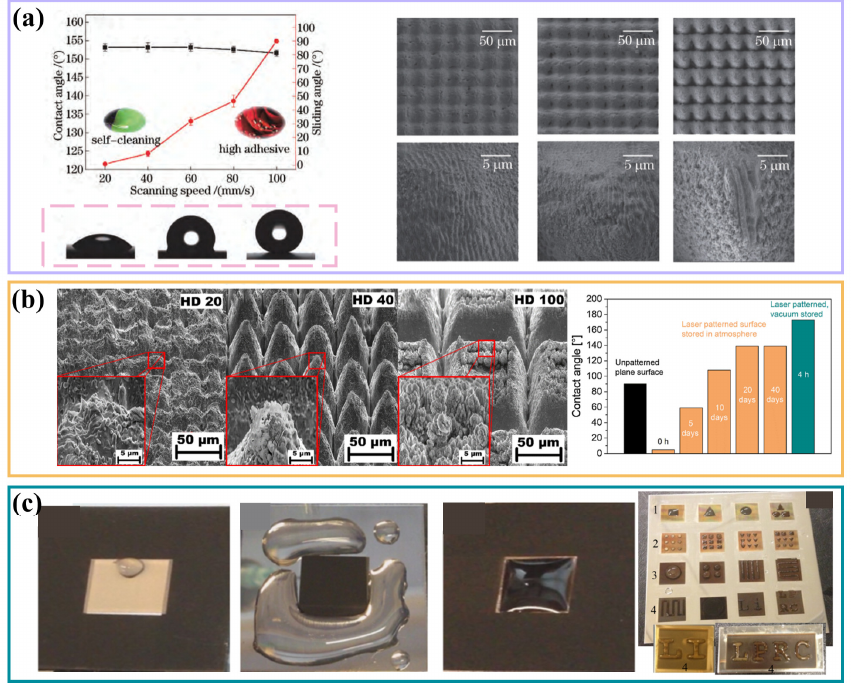
Figure 8. Laser-fabricated superhydrophobic surfaces: ( a ) Preparation of superhydrophobic surfaces by laser-chemical modification [99], ( b ) Laser and vacuum treatments achieve superhydrophobic surfaces [100], ( c ) Superhydrophobic or superoleophobic surfaces prepared by the nanosecond and picosecond laser [101].